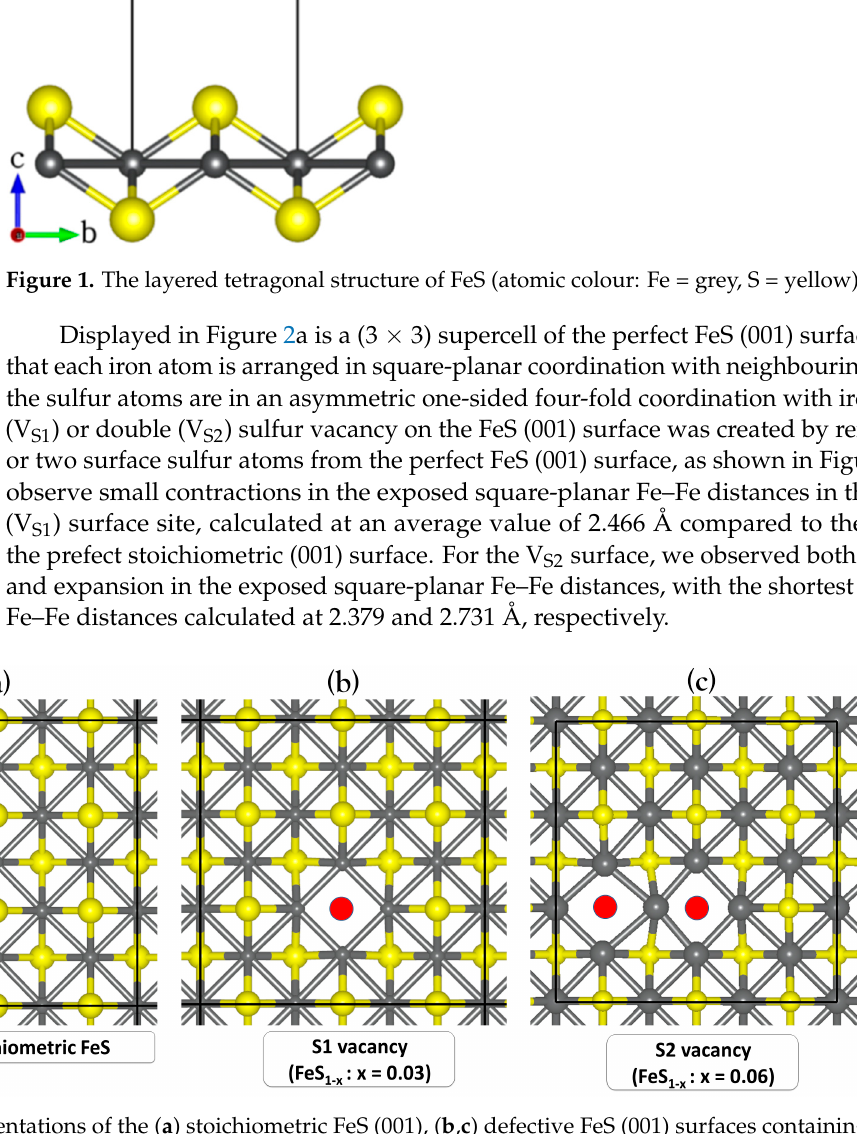
Figure 2. Schematic representations of the ( a ) stoichiometric FeS (001), ( b , c ) defective FeS (001) surfaces containing single (V S1 ) and double (V S2 ) sulfur vacancies. (colour code: Fe = grey, S = yellow and S vac ‐ site = red). The formation energy per vacancy ( E form ) of the surface containing n sulfur vacancies